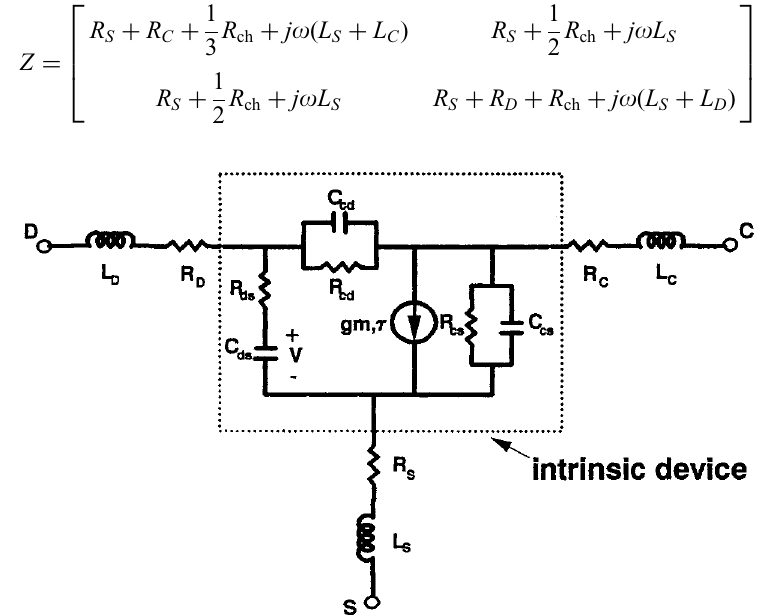
FIGURE 2 Small-signal equivalent circuit of a real space transfer